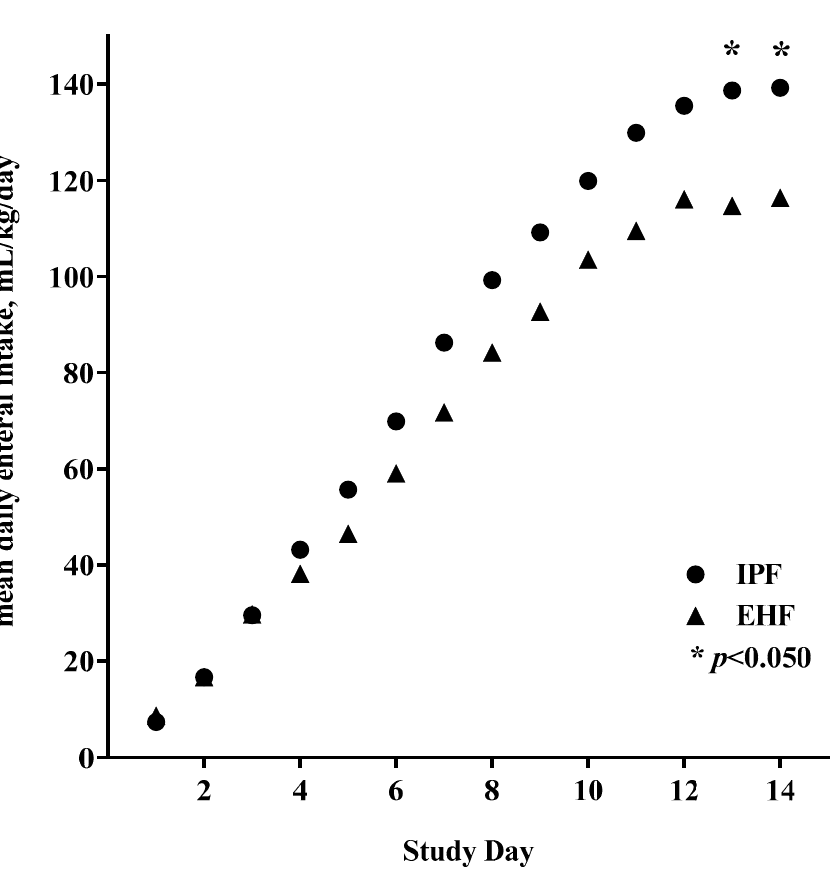
Figure 3. Mean daily enteral intake (mL/kg) began to diverge by study day 4; * significantly greater for the IPF ( ● ) vs. EHF ( ▲ ) group by day 13 ( p = 0.042) and continued at day 14 ( p = 0.047).